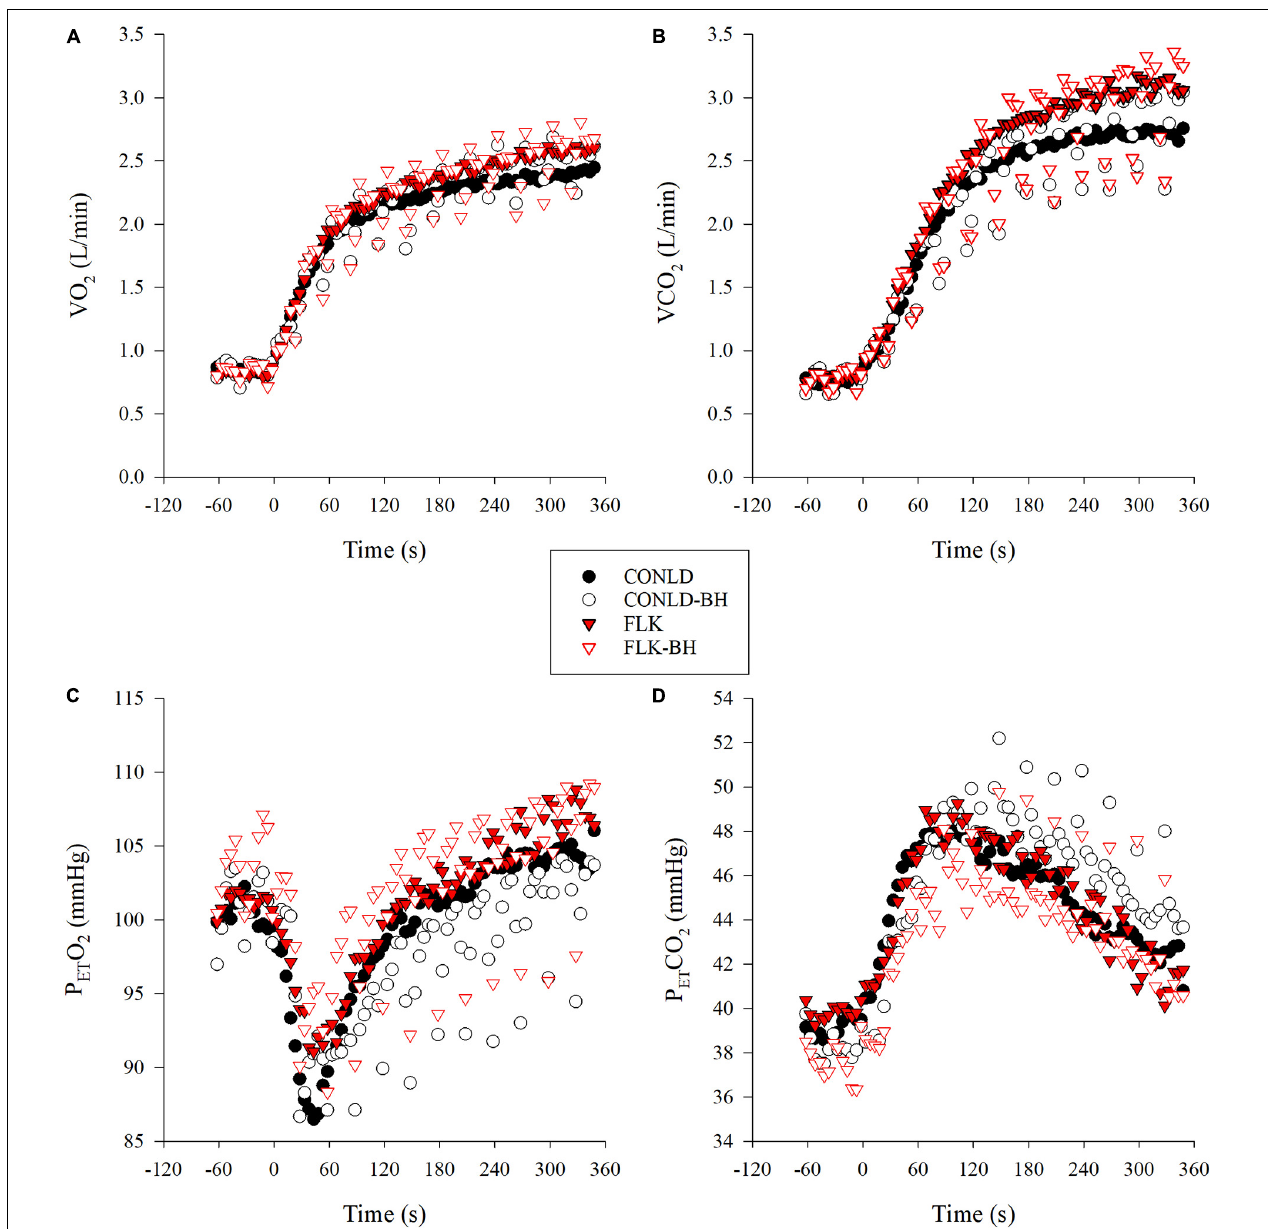
FIGURE 2 | Mean participant respiratory variables during constant A20% work (CONLD, filled circles), constant A20% work with 5 s BHs every 30 s (CONLD-BH, open circles), ?20% work with 5 s sprints at peak power output (PPO) every 30 s (FLK, filled red triangles) and A20% work with 5 s BHs, and sprints at PPO every 30 s (FLK-BH, open red triangles) for 6 min. (A) Oxygen consumption (VO 2 ), (B) carbon dioxide elimination (VCO 2 ), (C) end-tidal partial pressure of oxygen (P ET O 2 ), and (D) end-tidal partial pressure of carbon dioxide (P ET CO 2 ). Time 0 marks the start of the exercise transition. Data were interpolated from breath-by-breath to second-by-second and 5 s averaged for graphical